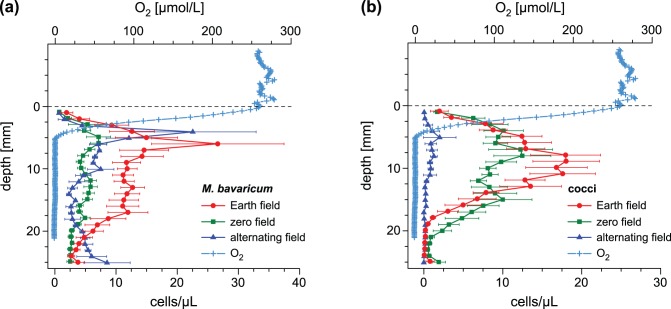
Mean MTB concentration profiles obtained during long-term exposures to different magnetic field configurations.Profiles refer to (A) M. bavaricum, and (B) cocci, during resilience experiments in the Earth magnetic field, zero field, and a daily switched vertical field. Error bars correspond to the standard deviation of individual minicors.